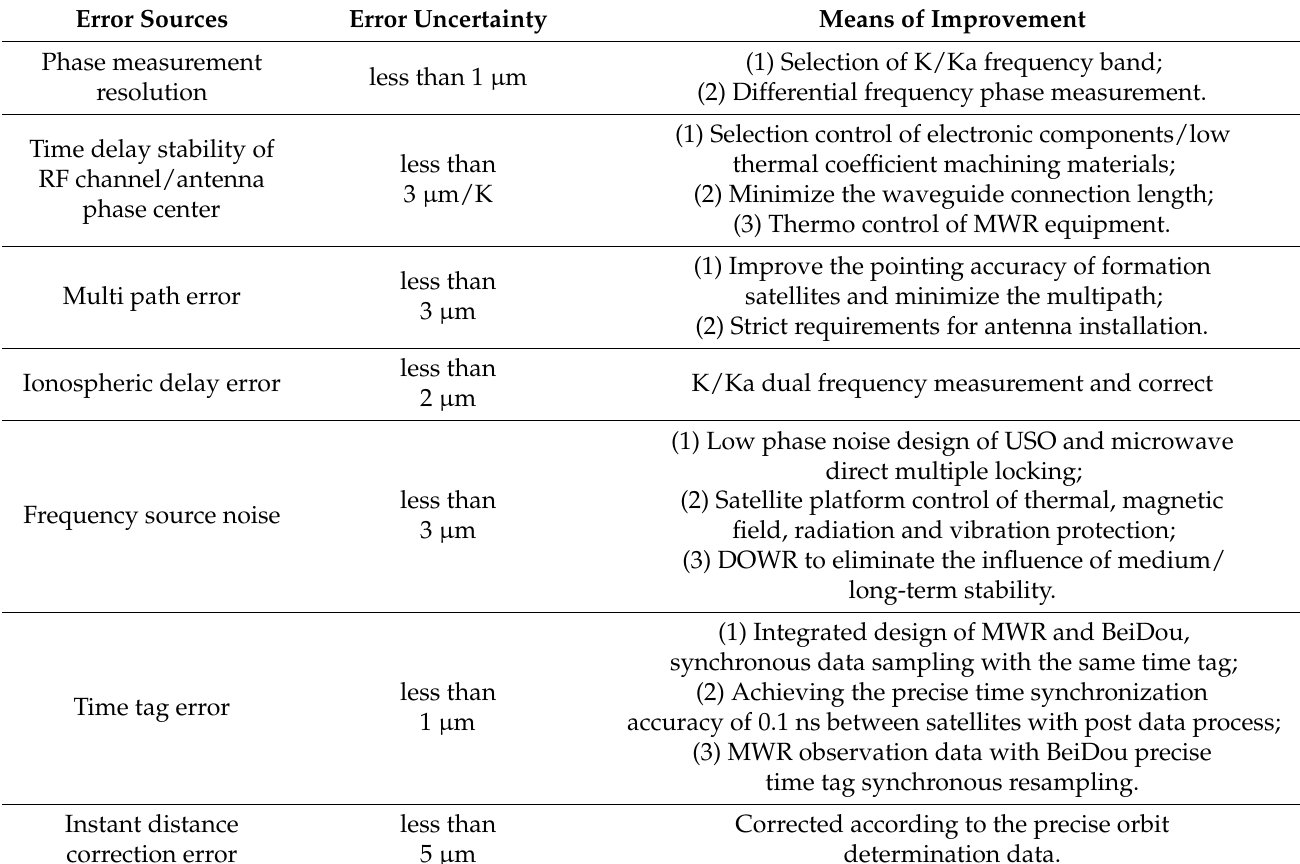
Table 1. The MWR LOS distance measurement error analysis between antenna phase